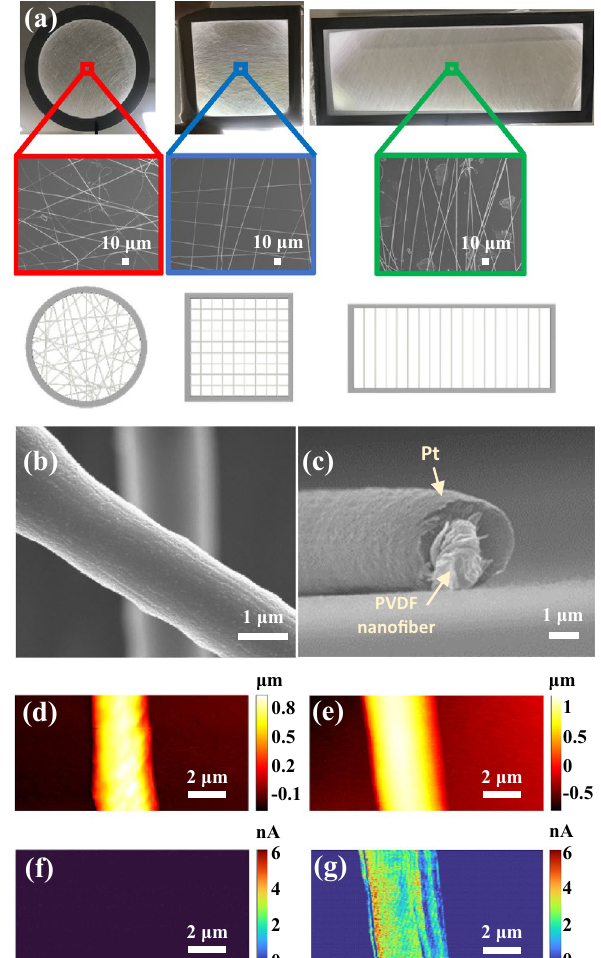
Figure 2. Topologies of the CS NF networks and characterization of a Pt-coated PVDF nanofiber. ( a ) PVDF nanofibers formed using the circular, square, and rectangular electrode collectors, and the magnified images of the nanofiber networks. The schematic diagrams show the simplified topologies of the nanofiber networks. SEM images of the ( b ) surface and ( c ) cross-section of a Pt-coated PVDF nanofiber, AFM topography images of a PVDF nanofiber ( d ) before and ( e ) after Pt sputtering, and C-AFM images of a PVDF nanofiber (f) before and ( g ) after Pt sputtering. The Pt sputtering time used for ( b ), ( c ), ( e ), and ( g ) was 4